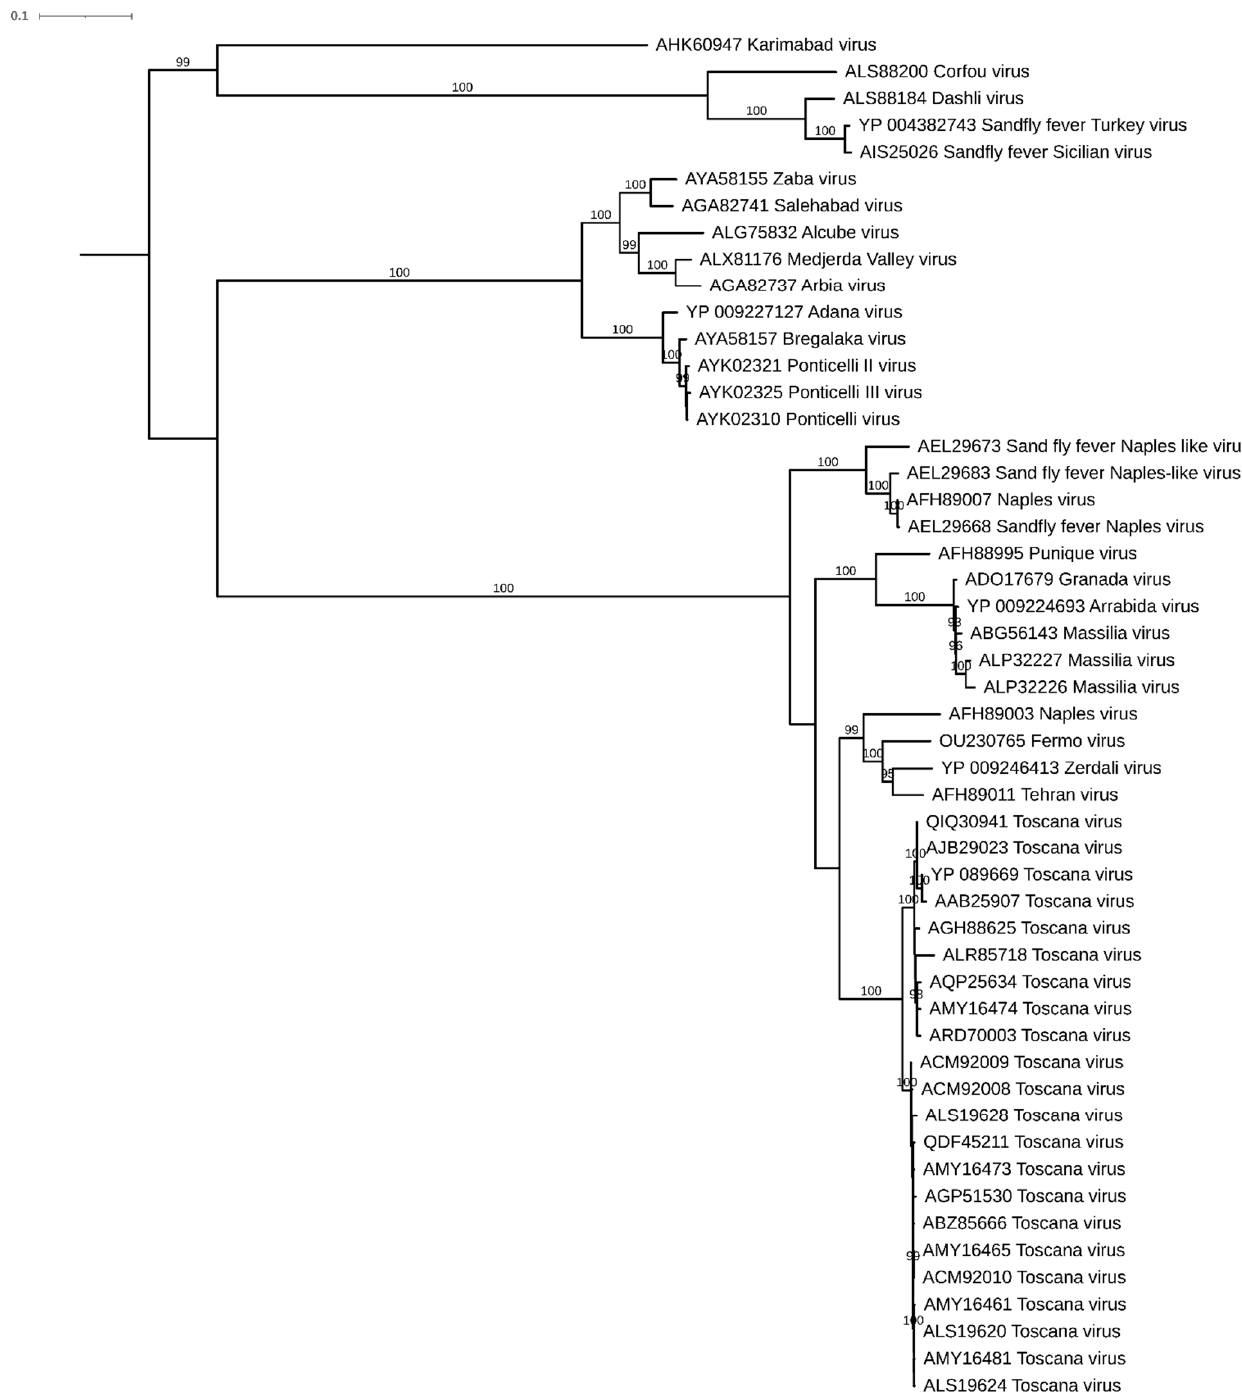
Figure 3. Neighbor joining tree of partial sequences of the S segments obtained from the field samples with reference to the strain collection day and utilization for isolation (i); the selected homologous sequences are available in GenBank (by referencing the accession number), bootstrap supports >90% showed near the branch.